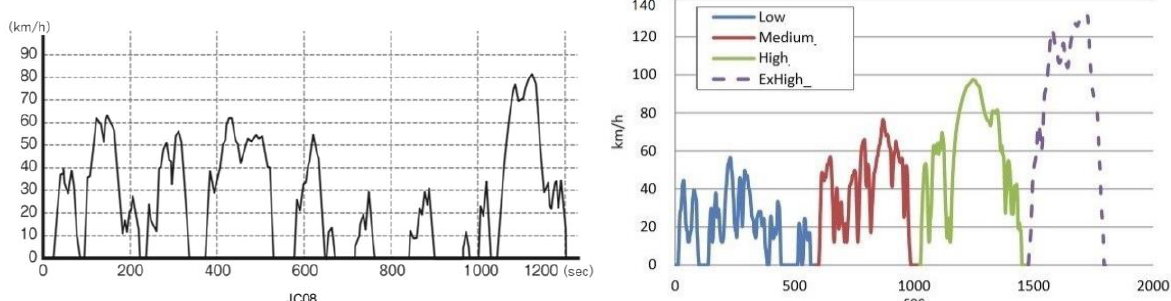
Figure 1. JC08 test cycle ( left ) and WLTC ( right ). X -axis is time (time) and Y -axis is speed (km/h). Source: https://www.mlit.go.jp/common/001184850.pdf (accessed on 21 April 2021); https://www.naltec.go.jp/publication/regula-